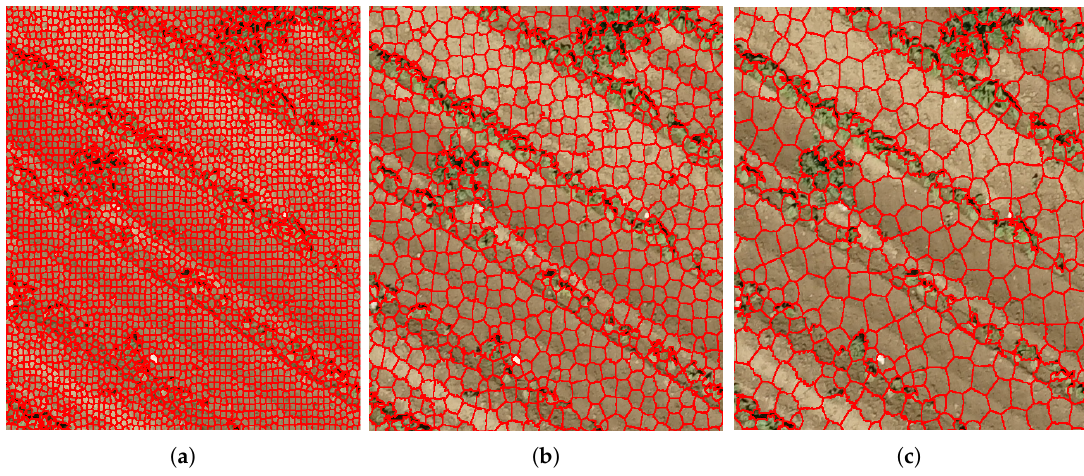
Figure 4. Examples of superpixels computed on images with the dimensions N = 7360 × 4912 pixels. From left to right: the image is segmented with a number of superpixels equal to 0.5% × N, 0.1% × N, and 0.01% × N, respectively.